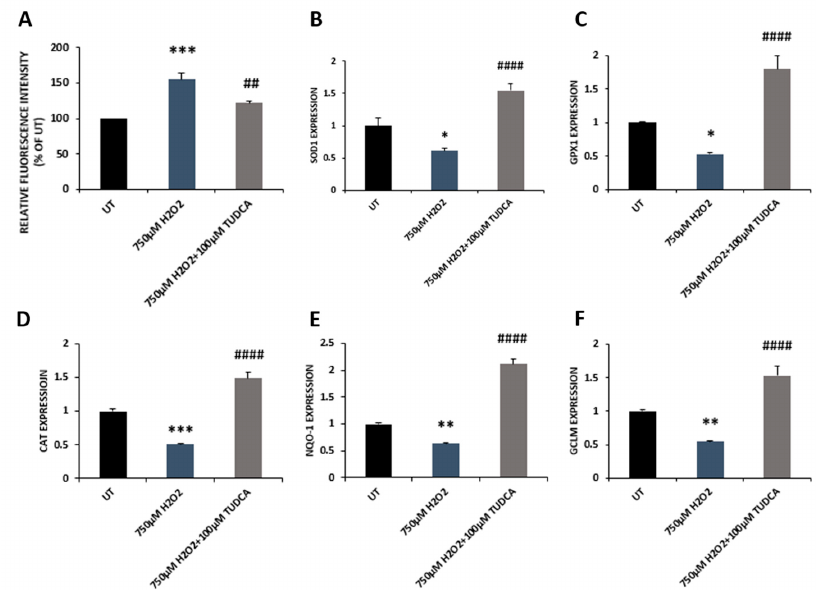
Figure 3. TUDCA reversed effects of H 2 O 2 on ROS production and antioxidant gene expression. ( A ) ROS generation in control, H 2 O 2 , and H 2 O 2 -plus-TUDCA-treated cells was measured using DCFH-DA. ( B–F ) qRT-PCR was used to measure expression of antioxidant genes, superoxide dismutase 1 ( SOD1 ), glutathione peroxidase 1 ( GPX1 ), Catalase (CAT), NAD(P)H dehydrogenase (quinone) 1 ( NQO-1 ) and glutamate-cysteine ligase modifier subunit ( GCLM ) . Data were shown as mean ± SEM. * p < 0.05, ** p < 0.01, *** p < 0.001, 750 µM H 2 O 2 vs. untreated (UT) control; ## p < 0.01, #### p < 0.0001, 750 µM H 2 O 2 plus TUDCA vs. 750 µM H 2 O 2 .